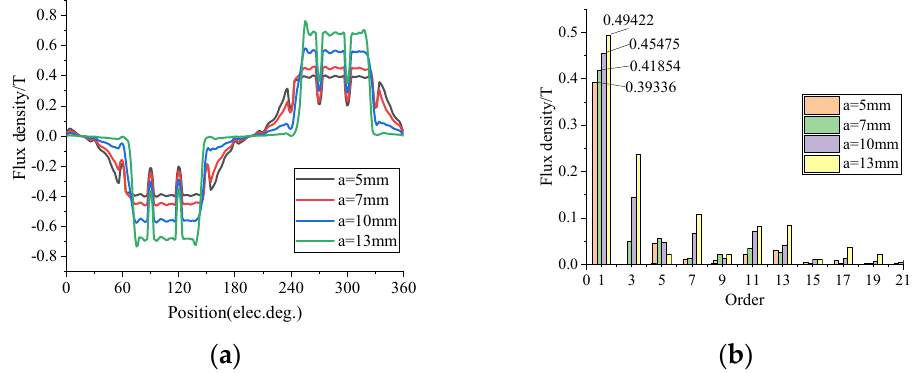
Figure 12. Air gap flux density with different lengths of magnetic barriers. ( a ) Waveform of air gap flux density; ( b ) harmonic spectra.